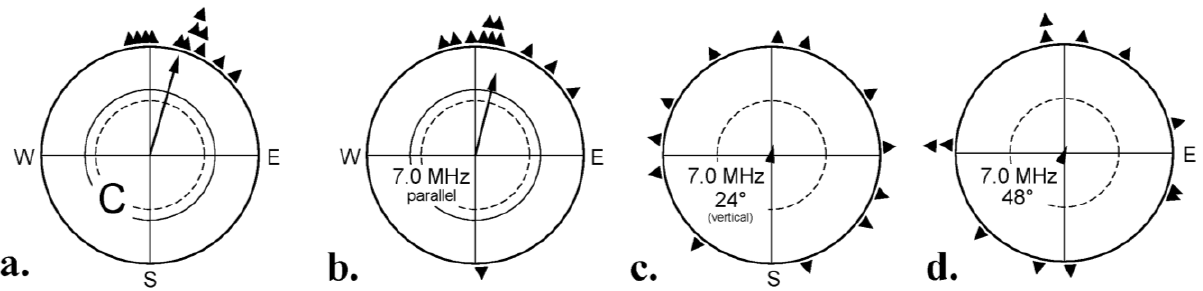
Figure 6. Testing robins with radio frequency fields of 7 MHz, 470 nT, added in different alignments with respect to the vector of the local geomagnetic field. ( a ) Control: geomagnetic field only; ( b ) radio frequency field added parallel to the magnetic vector, that is 24° to the downward direction; ( c ) added vertically, 24° to the magnetic vector; ( d ) added 48° to the magnetic vector, which means 24° to the downward direction— Symbols as in Figure 1b (data from